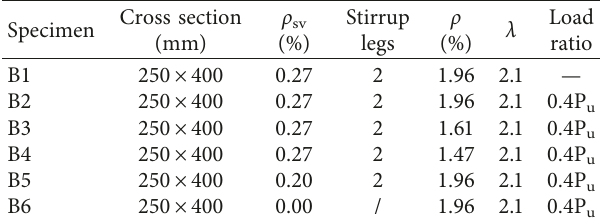
Table 1: Specimens parameters. Cross section Specimen (mm)